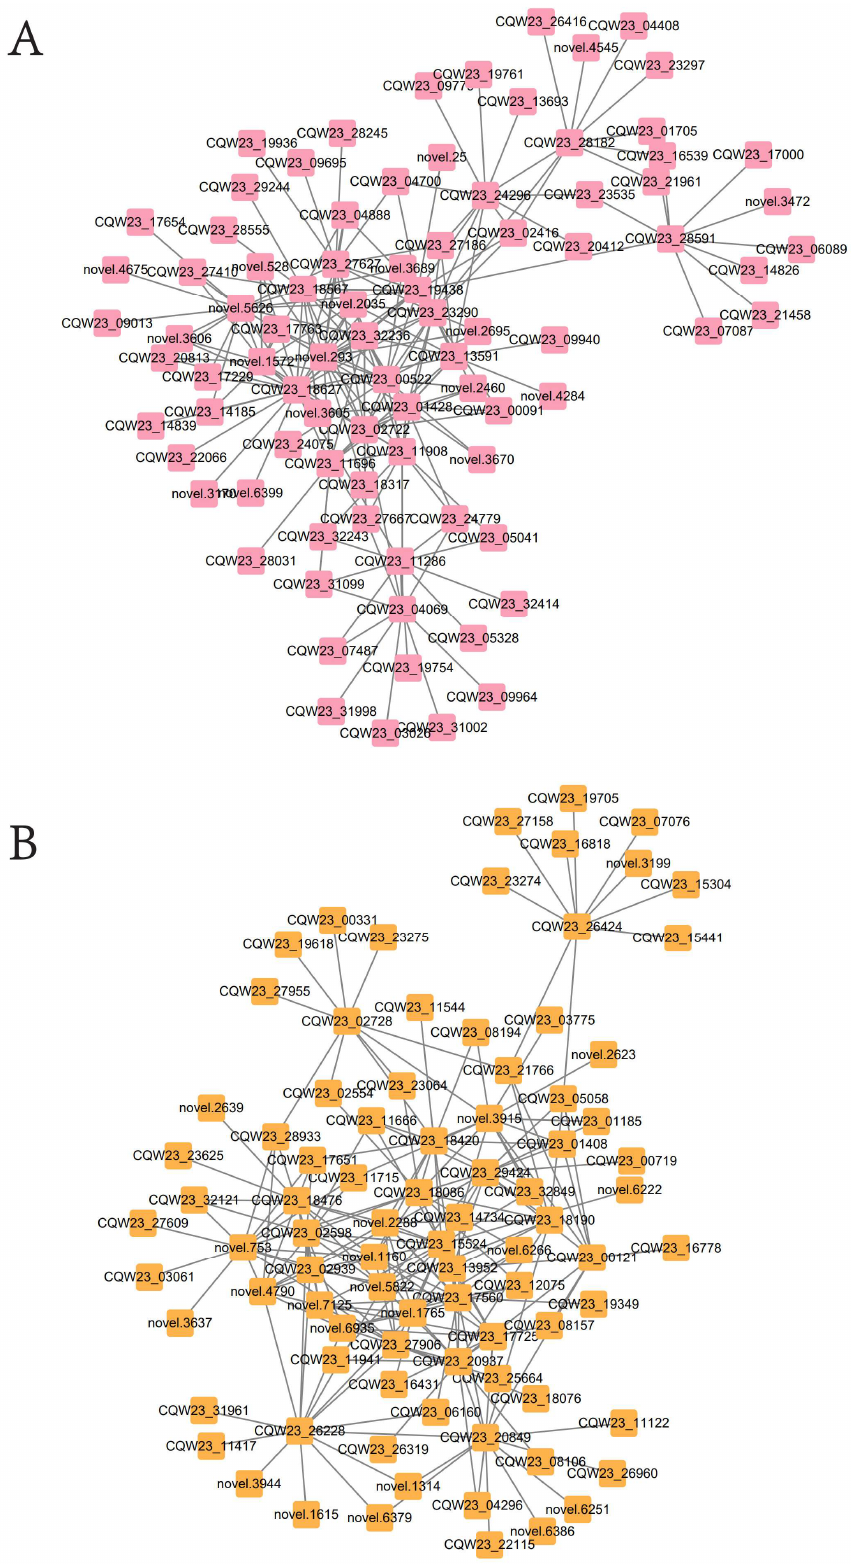
Figure 6. ( A ) Pink module genes correlation network; ( B ) yellow module genes correlation network.